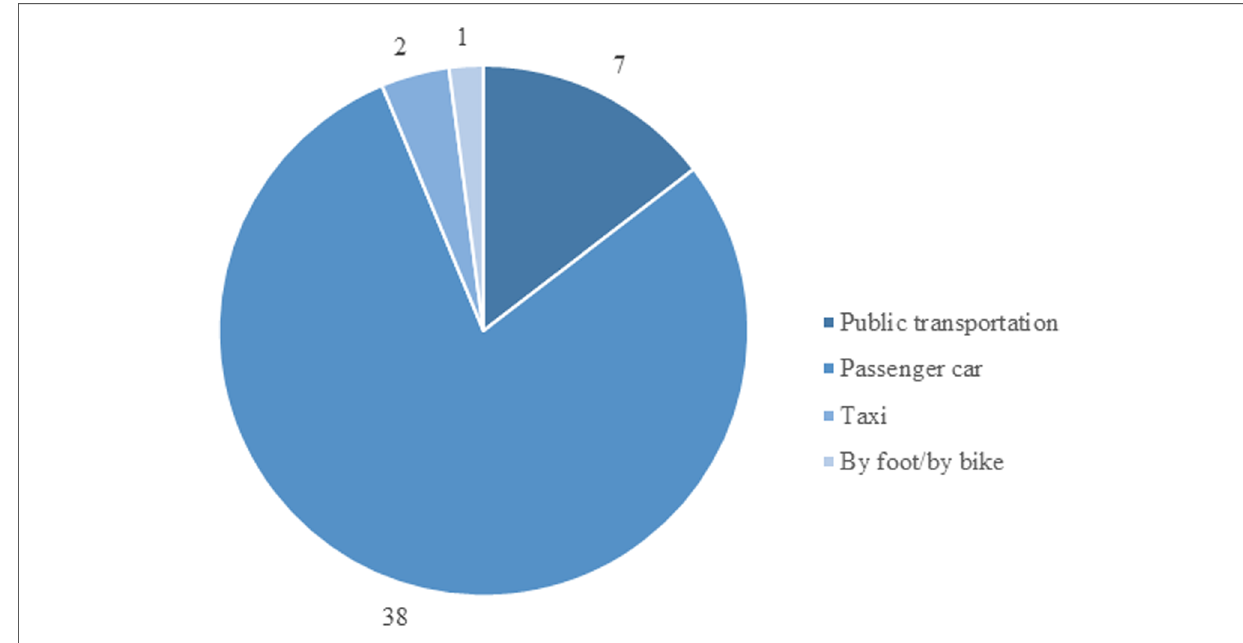
FIGURE 4 Choice of the mode of transportation by